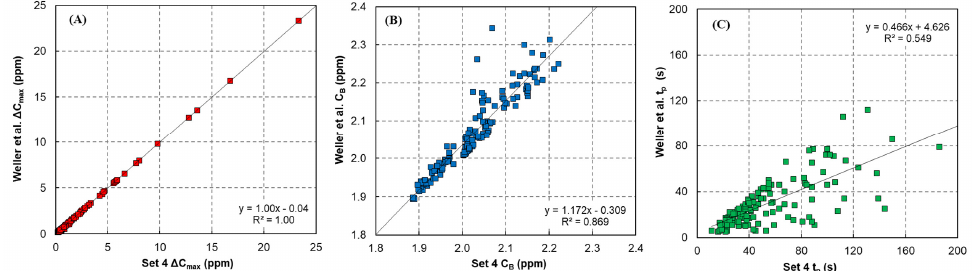
Figure 6. Scatter plots comparing results of parameter set 4 with Weller et al.’s method [21] for ( A ) peak maximum concentration, ( B ) peak baseline concentration, and ( C ) peak duration.